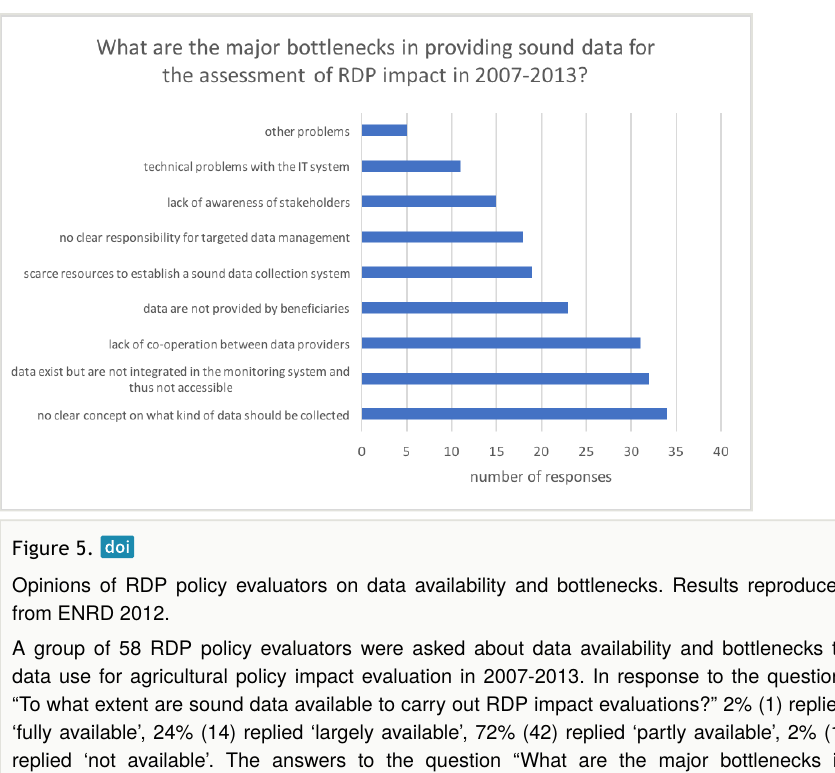
Opinions of RDP policy evaluators on data availability and bottlenecks. Results reproduced from ENRD